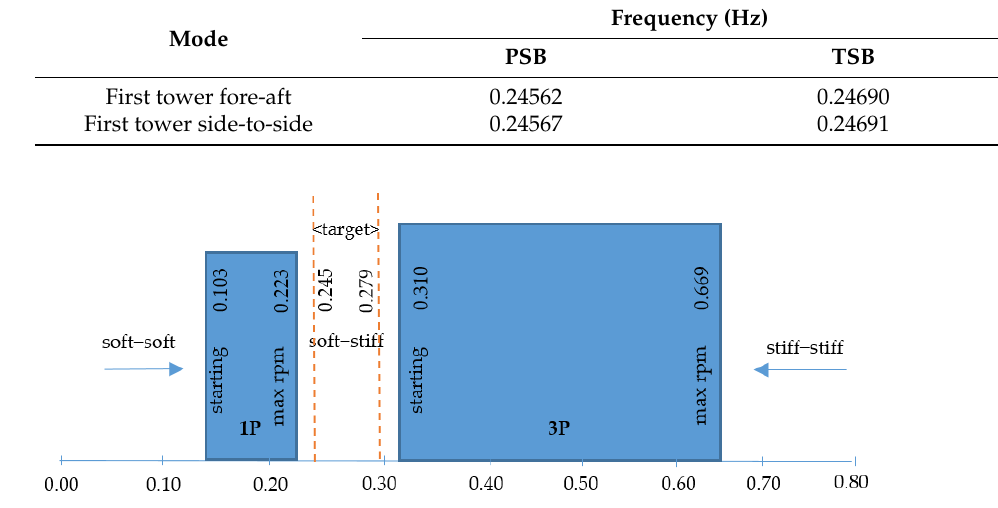
Figure 16. Mode shapes. Table 7. First natural frequencies of SBs. Mode